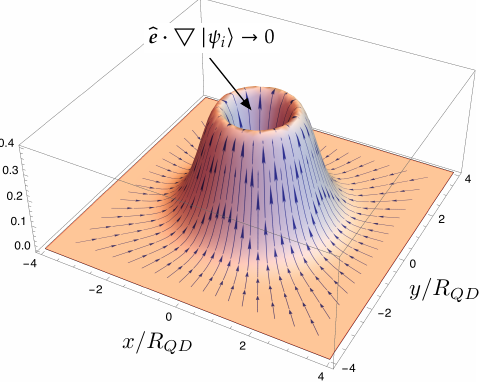
ψ i , in the dot. Note that (cid:98) e · (cid:53) | (cid:105)